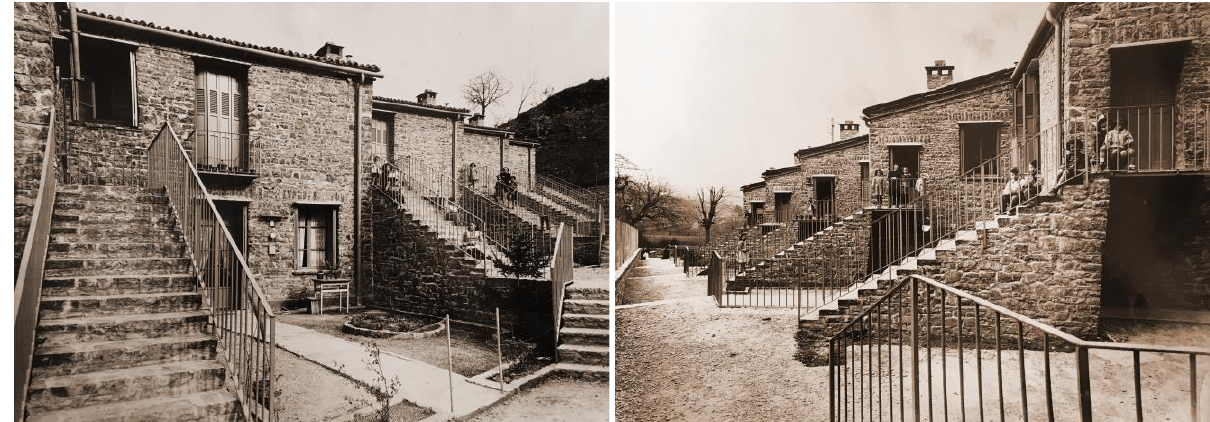
Figure 8. The Fanfani alla Fara houses after the construction in the 50s of the last